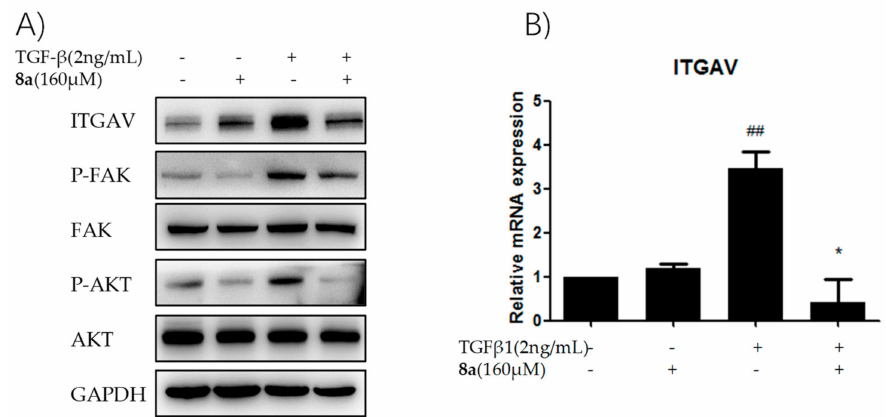
Figure 7. 8a plays an anti-hepatic fibrosis e ff ect via supressing the intergrin-focal adhesion pathways. (A) E ff ects of compound 8a on inhibiting integrin α V and inhibiting p-FAK and p-AKT on protein level in LX-2 cells after 8a treatment for 24 h; (B) E ff ects of compound 8a on inhibiting integrin α V on mRNA level in LX-2 cells after 8a treatment for 24 h. The protein expression levels were analyzed by Western Blot assay, and normalized against GAPDH. The mRNA expression levels were analyzed by RT-PCR. Data were presented as the mean ± SEM, (##) p < 0.01 as compared to that of control group; (*) p < 0.05 as compared to that of TGF β 1